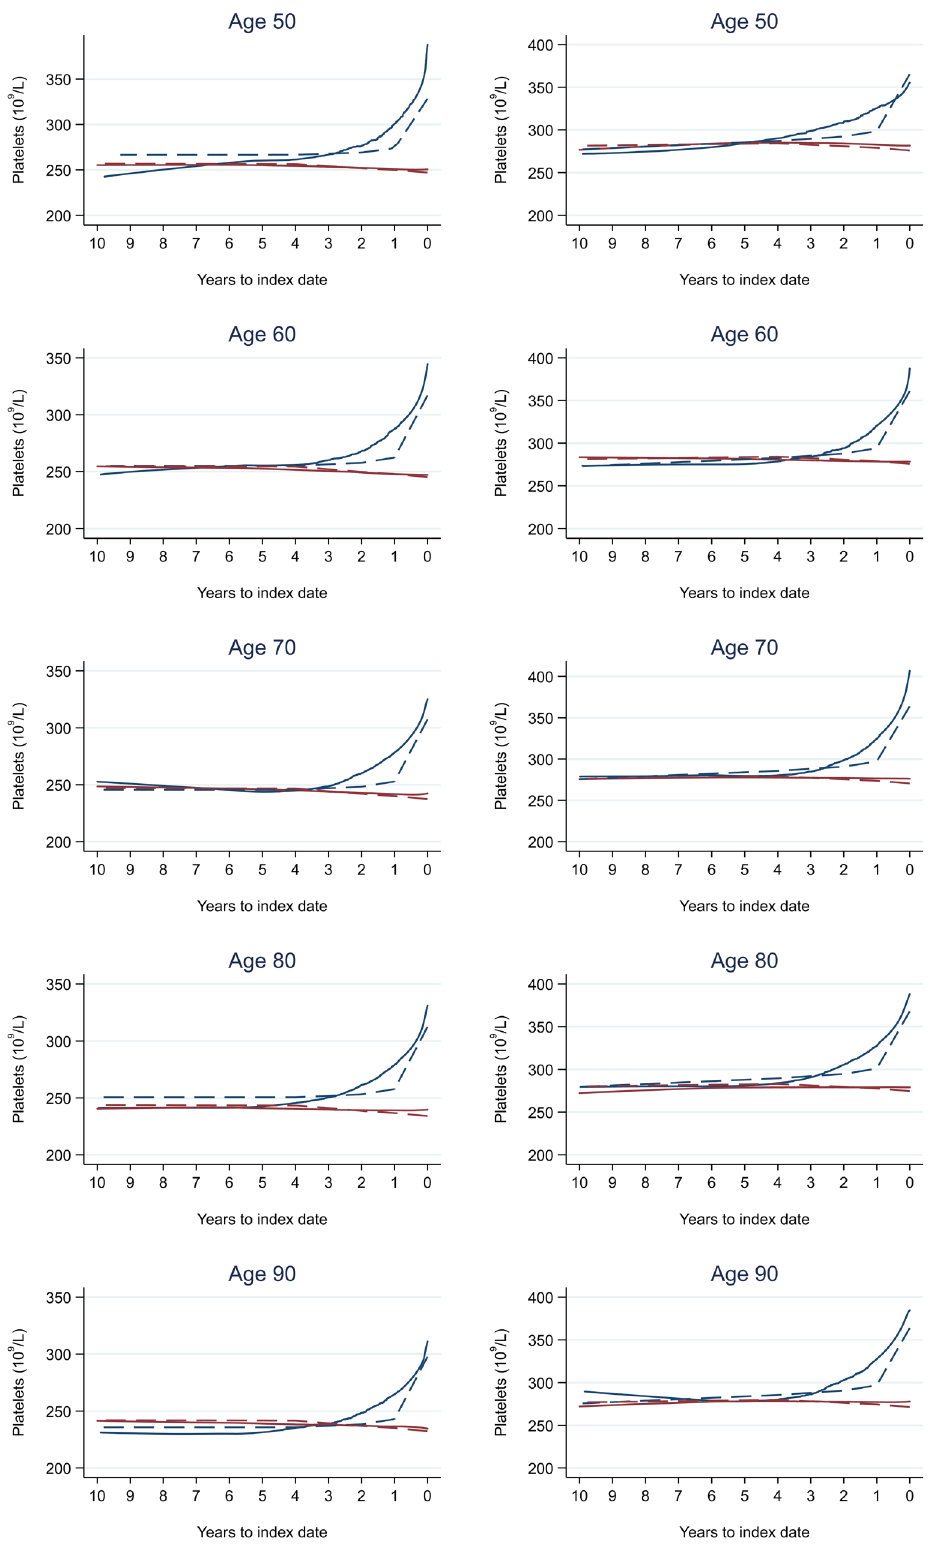
Figure 10. Platelets trends between cases and controls, by age at index date 1,2 . 1 Index date was the date of diagnosis for cases and a randomly selected date in the patient’s study period for controls. 2 LOWESS trends are age (+/- 3 years) and modelled (fixed effects) trends are taken at that specific age. Legend: males (left) and females (right). Colorectal cancer (blue line) and no cancer (red line). LOWESS trend (solid line) and modelled trend (dashed line).